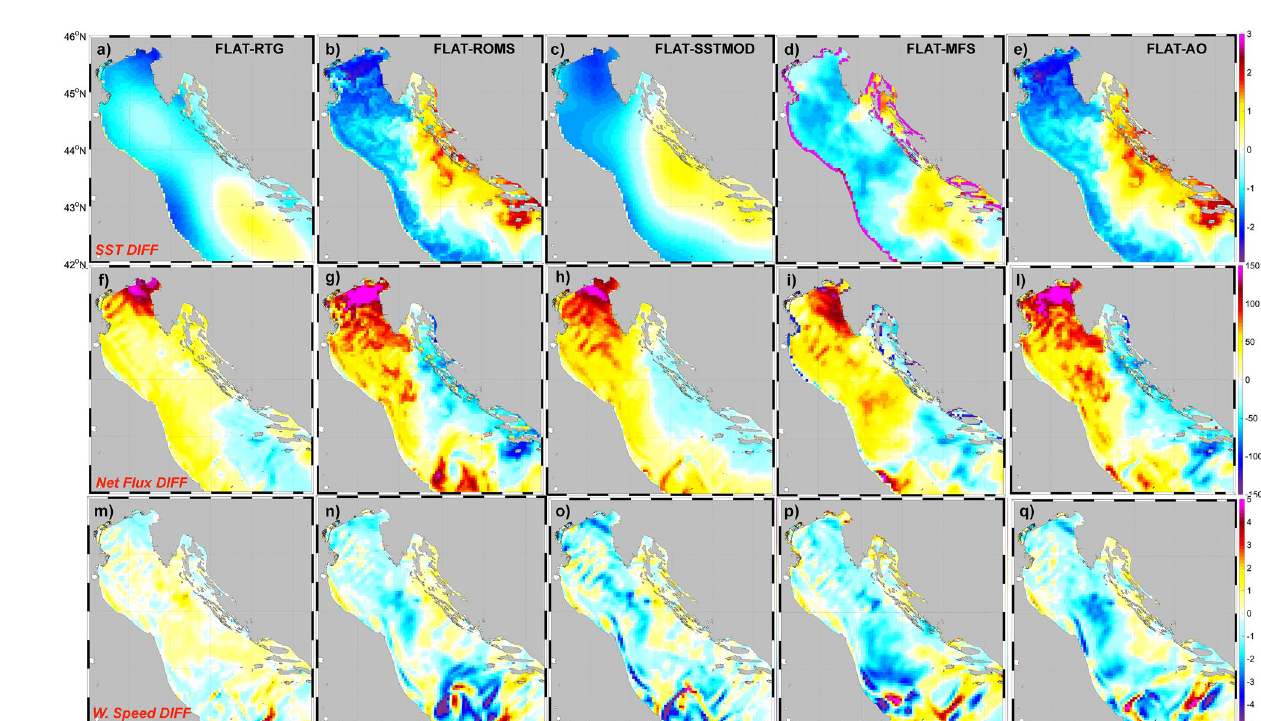
Figure 2. Upper row: Sea Surface Temperature (SST) difference between the FLAT run and the other simulations (in °C) at 06 UTC, September 26. Middle row: Surface Heat Fluxes difference between the FLAT run and the other simulations (in W m −2 ). Bottom row: 10 m wind speed difference between the FLAT run and the other simulations over sea surface. Due to the marked similarity in terms of SST with the AO run, the results for AOW run are not shown here (see Fig.